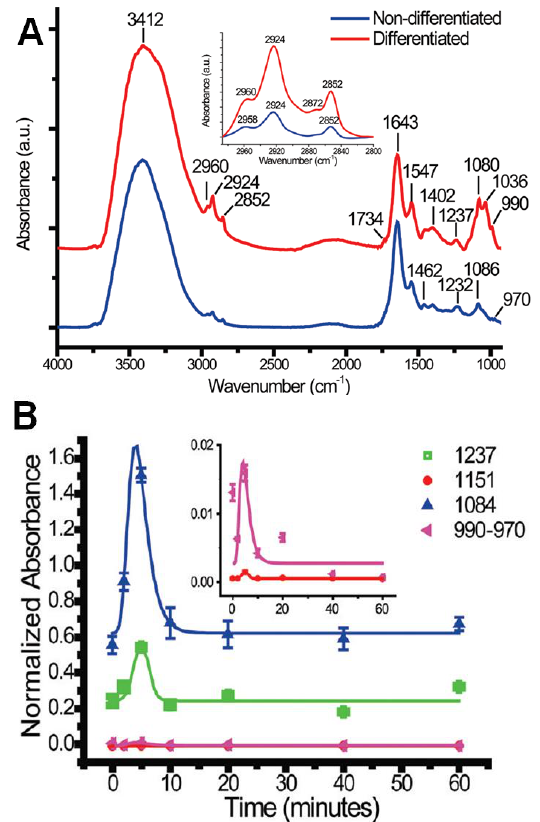
Figure 8. ( A ) Comparison of IR absorption spectra of control ( blue ) and NGF-treated ( red ) PC12 cells; and ( B , C ) Time absorbance of bands in the fingerprint region from short-term ( B ) and long-term ( C ) NGF-treatments. (Reprinted with permission from [78]. Copyright 2012 American Chemical